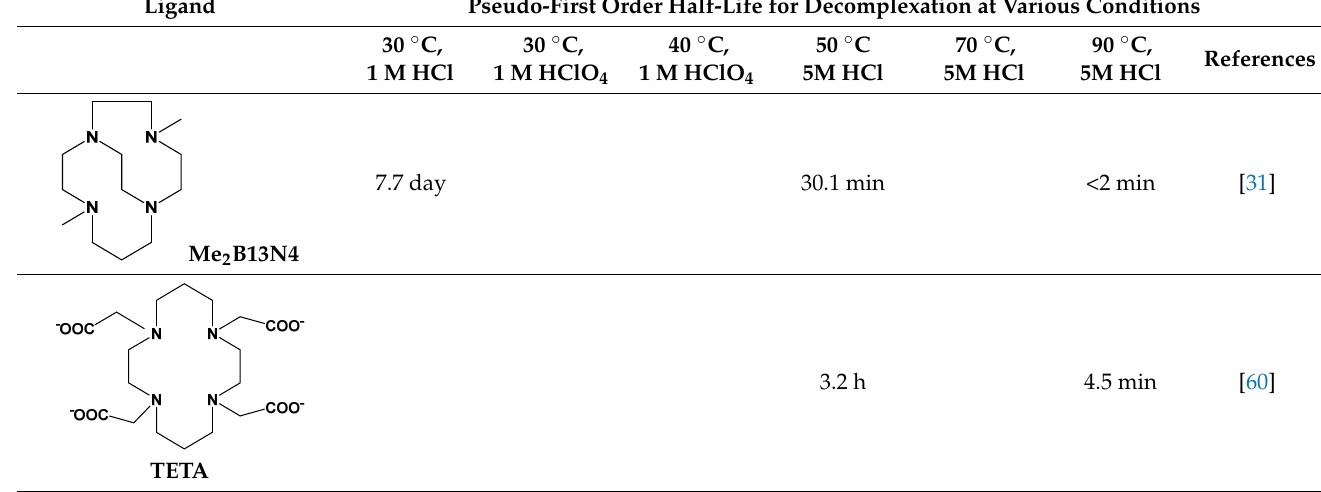
Table 3. Cont. Pseudo-First Order Half-Life for Decomplexation at Various